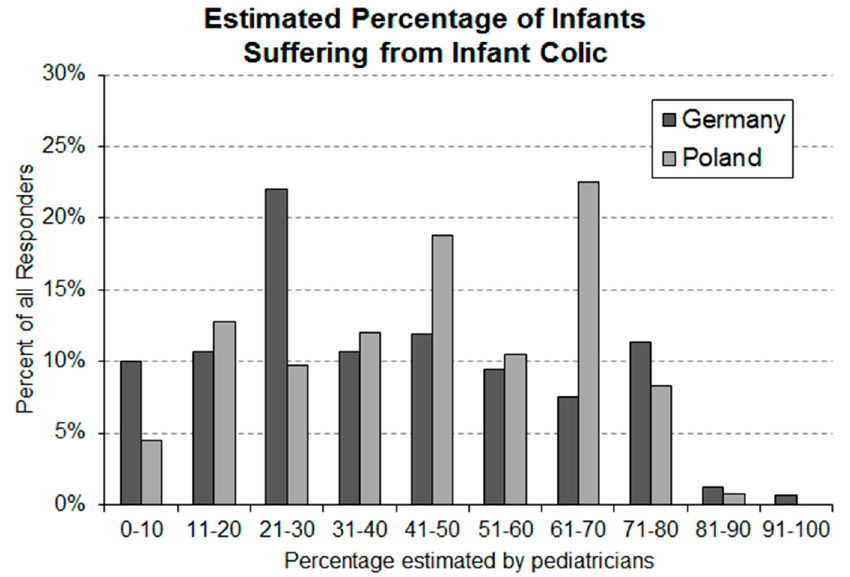
Figure 1. Frequency distribution of German ( n = 152) and Polish ( n = 133) pediatricians’ estimates of average occurrence rates of infantile colic in infants aged 0–5 months.